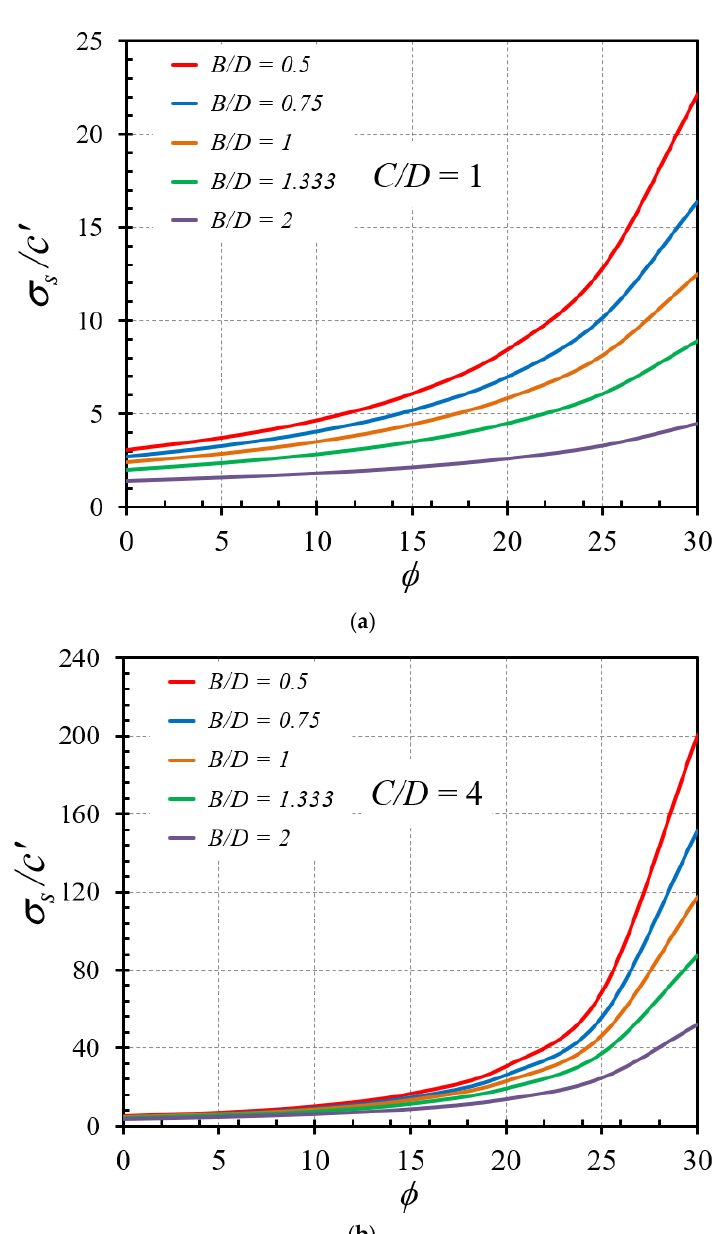
Figure 3. Influence of ϕ on the stability factors σ s /c' of horseshoe tunnels with γ D/c' = 0: ( a ) C/D = 1 and ( b ) C/D = 4.